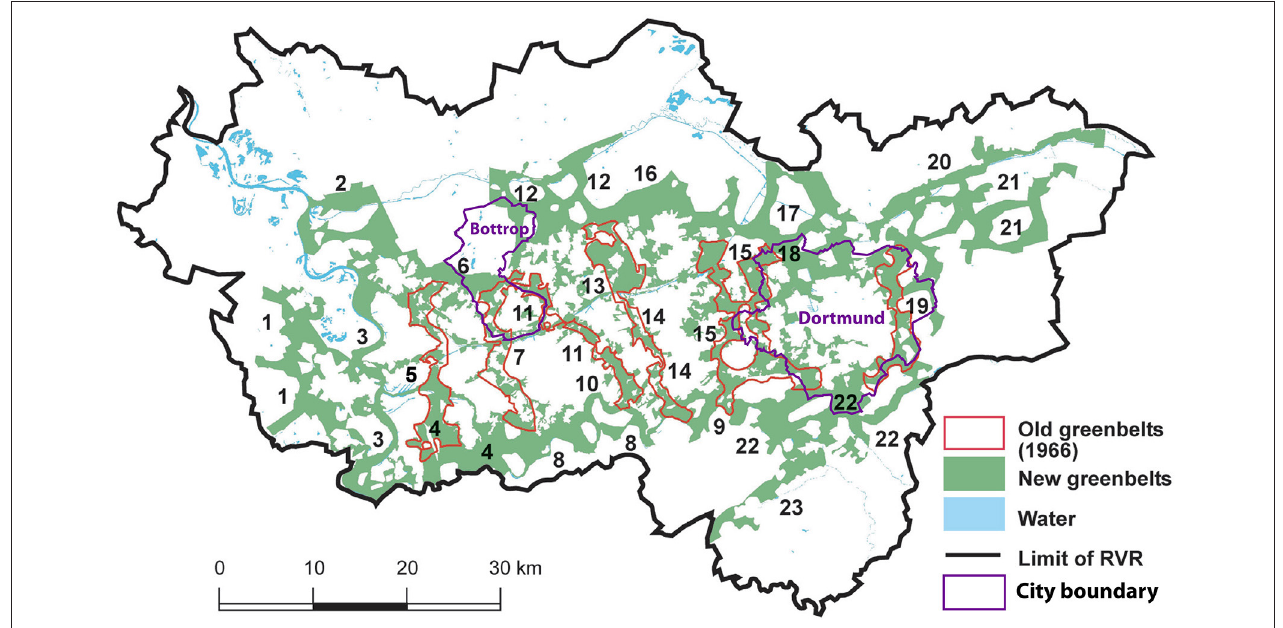
FIGURE 2 | Greenbelts in the Ruhr (modified from source: Zepp, 2018,